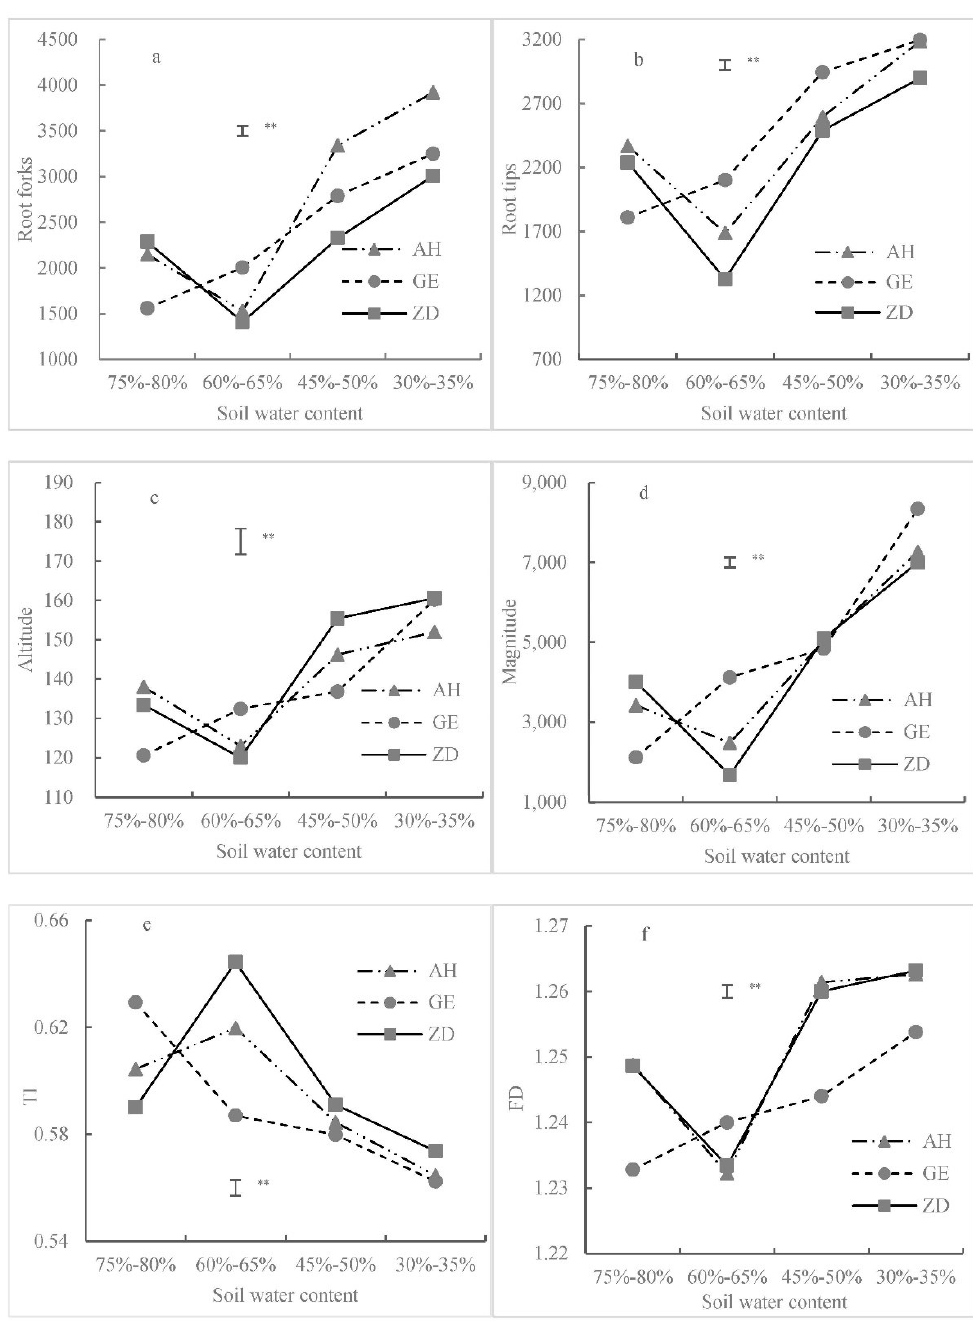
Figure 6. Interactions between soil water content (75 – 80%, 60 – 65%, 45 – 50%, and 30 – 35% of water- holding capacity) and cultivars (AH: Aohan; GE: Golden Empress; ZD: Zhaodong) on ( a ) number of root forks, ( b ) number of root tips, ( c ) altitude, ( d ) magnitude, ( e ) topological index (TI), and ( f ) fractal dimension (FD) of the root system of alfalfa. ** p < 0.01.